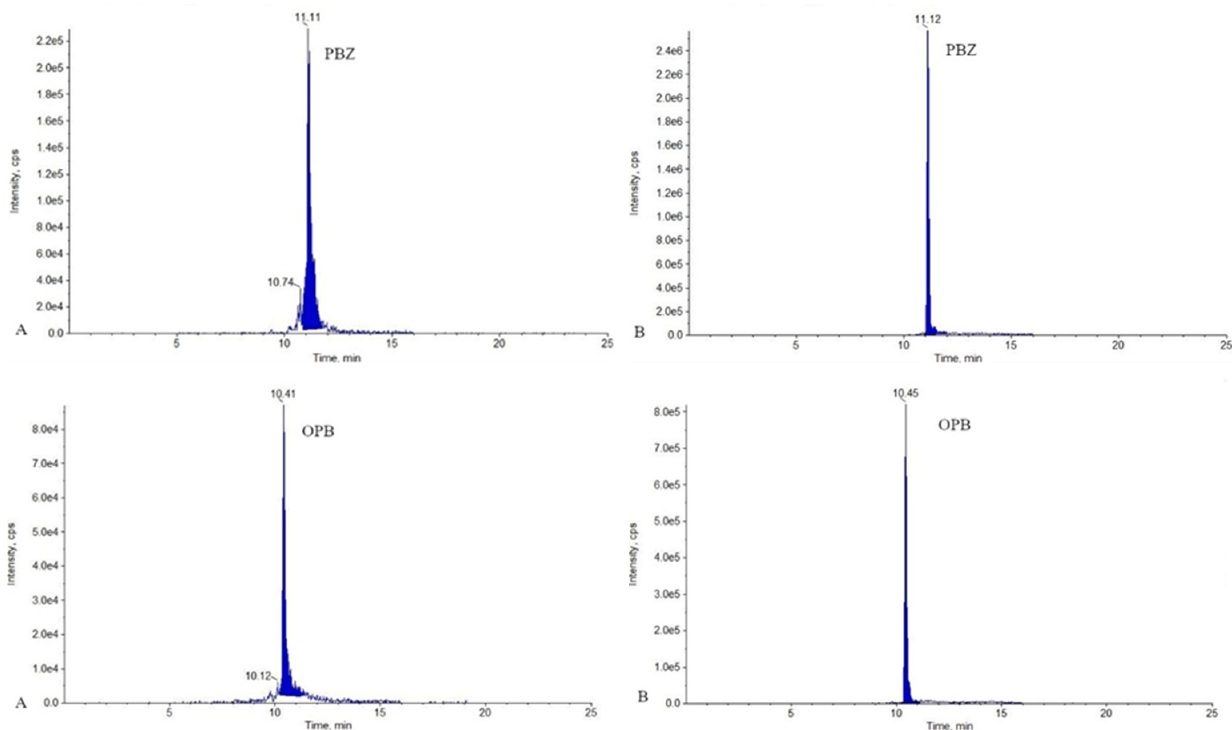
Figure 1. Ion chromatograms for PBZ and OPB (transitions used for quantification) obtained from bovine milk sample spiked at level 1.0 MRL. Sample A was reconstituted in 0.1 mL of mobile phase and sample B in 0.1 mL of DMSO.